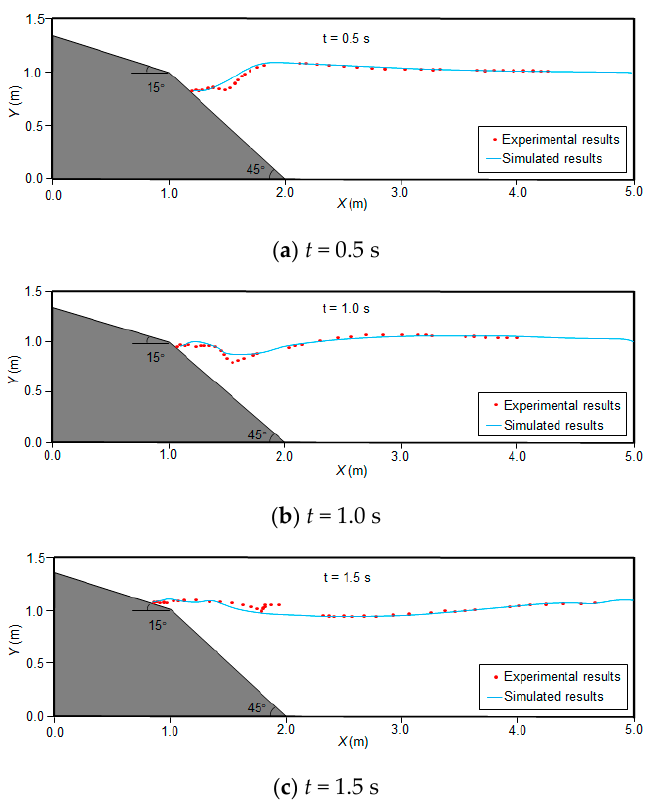
Figure 7. Comparison between the simulated and observed wave profiles at different times: ( a ) t = 0.5 s; ( b ) t = 1.0 s; ( c ) t = 1.5 s. 0.5 s; ( b ) t = 1.0 s; ( c ) t = 1.5